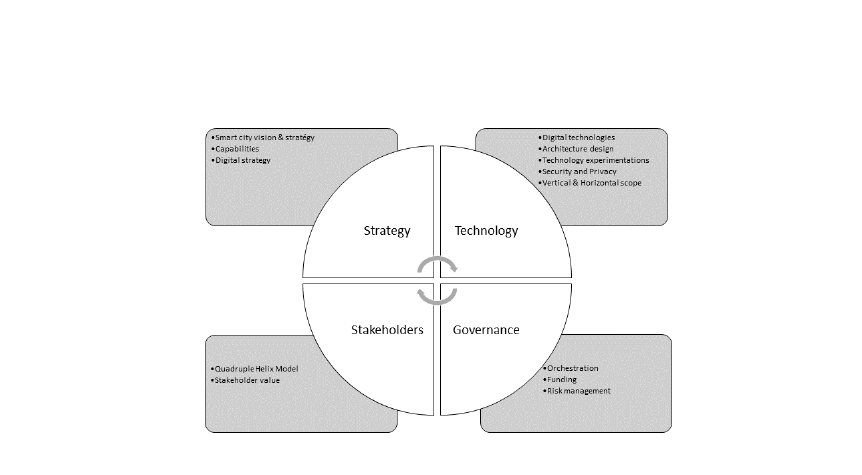
Figure 1. A conceptual model for the smart city design [11]